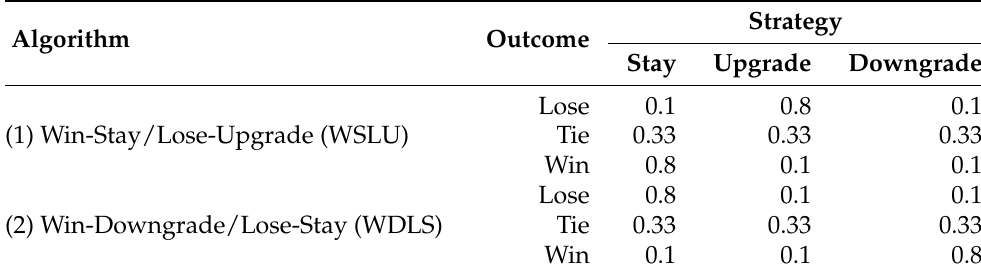
Table 3. Two algorithms used to play against human participants in the Experiment